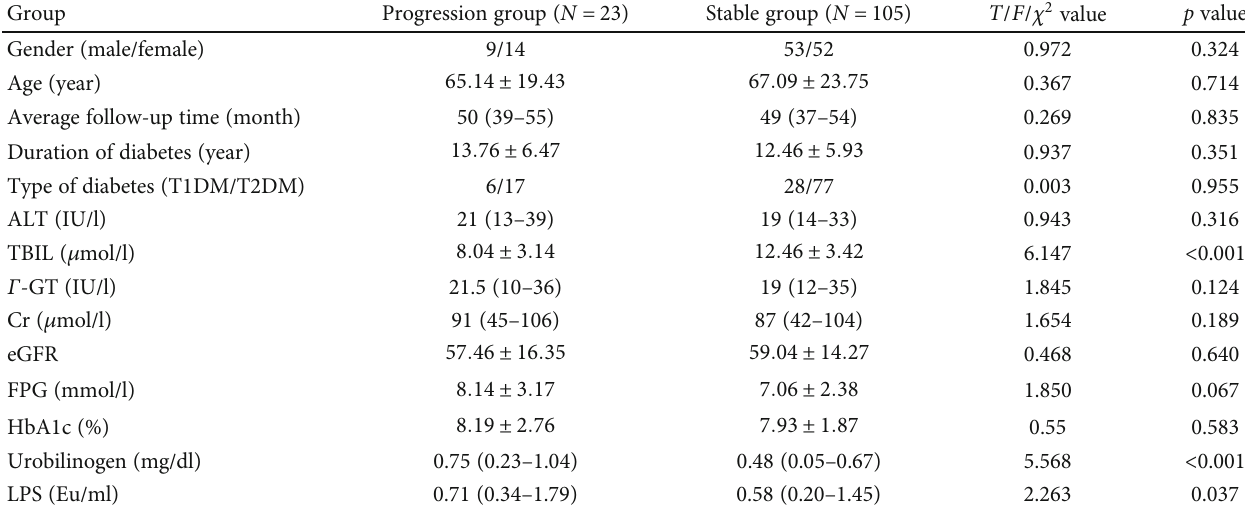
Table 2: Characterization of DR individuals in an outpatient visit.